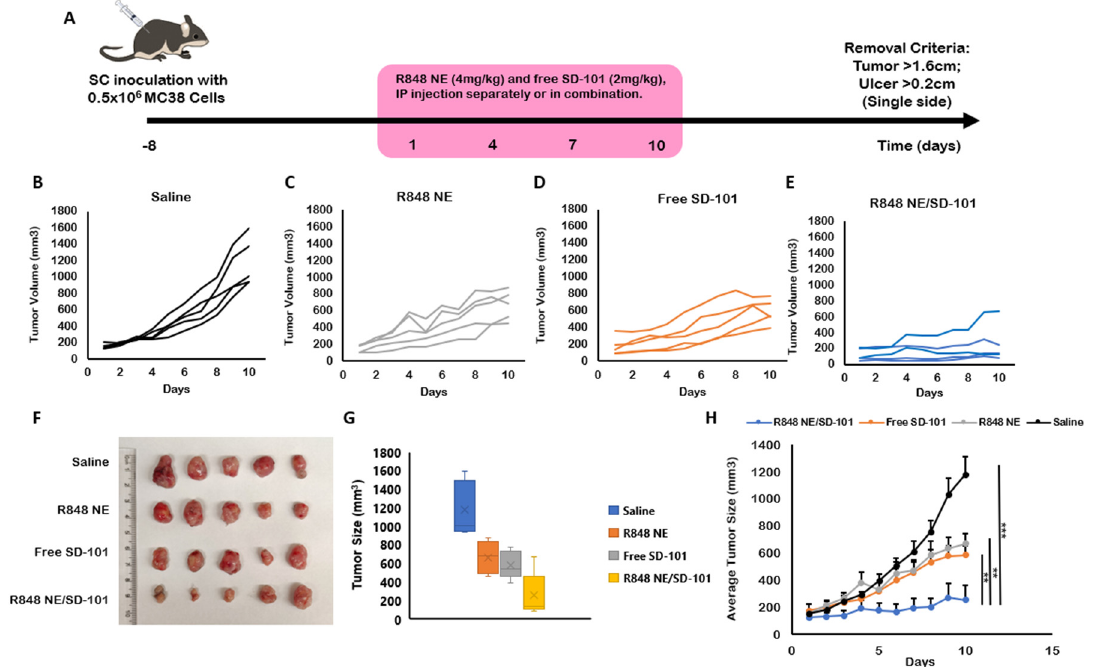
Figure 5. R848 NE and SD-101 treatments of murine colon adenocarcinoma (MC38) syngeneic C57BL/6N mouse model. ( A ) Timeline for MC38 inoculation and treatment regimen. The mice were inoculated with 0.5 million MC38 subcutaneously on the right flank. Treatments began at 8 days after inoculation when tumors became palpable. Treatments were given every 3 days for up to 4 doses. Mice were euthanized after the fourth dose on day 10. ( B – E ) Tumor growth over time for individual mice treated with ( B ) saline, ( C ) R848 NE, ( D ) SD-101, or ( E ) R848 NE/SD-101 combination ( n = 5). ( F ) Images of MC38 tumor tissues were collected at day 10 with measured ( G ) tumor sizes. ( H ) Average tumor growth for each treatment group within 10 days. Data are presented as means ± SEM ( n = 5). One-way ANOVA: ** p < 0.01, *** p < 0.001.